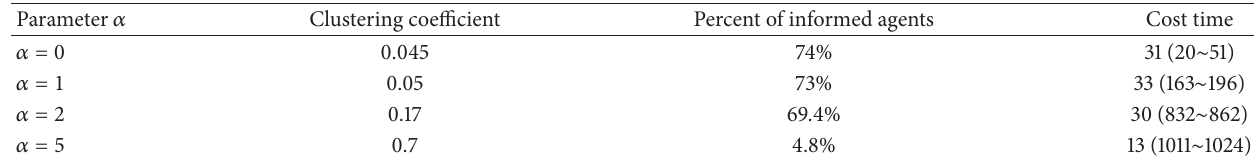
Figure 6: The rumor diffusion status with different values of 𝛼 (0, 1, 2, 5), where 𝛽 = 10 , 𝑚 = 5 , 𝑝 1 = 1 , 𝜆 = 0.3 , 𝜅 = 0.00005 , 𝜏 = 0.95 , = 100 , 𝜑 = 0.1 , and 𝑝 = 1 . 𝛾 = 0.7 , 𝜔 = 0.9 , 𝜀 = 0.3 , 𝑝 0 1 Table 1: Comparisons of rumor diffusion status with different 𝛼